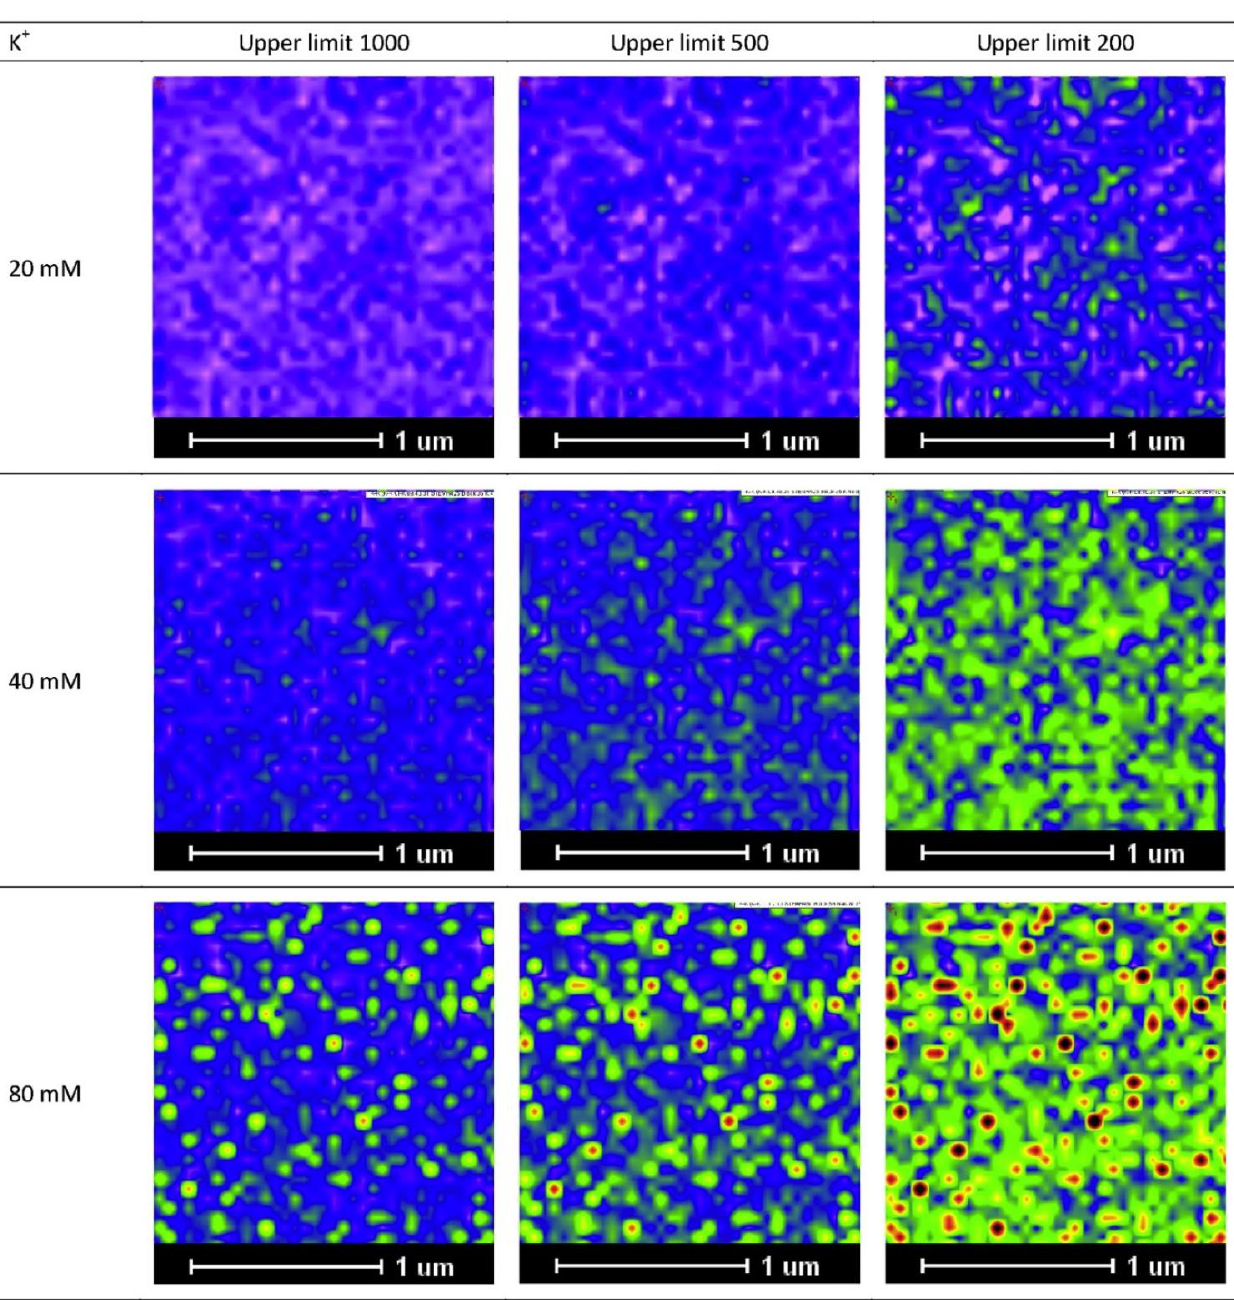
Figure 3. Representative K + images of 5% agar containing 20, 40, and 80 mM KCl. The distributions of elements at low concentrations were enhanced by adjusting the scaling. Images are shown for maximum values (upper limits) of 1000, 500, or 200. In all cases, the minimum value was fixed at